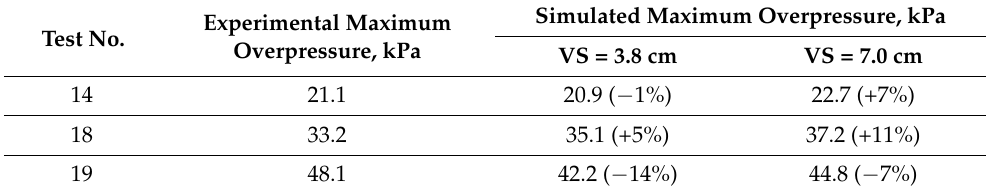
Table 3. Comparison of the experimentally measured maximum overpressure peaks to simula- tion results for the employed volumetric source approaches (in brackets relative difference from